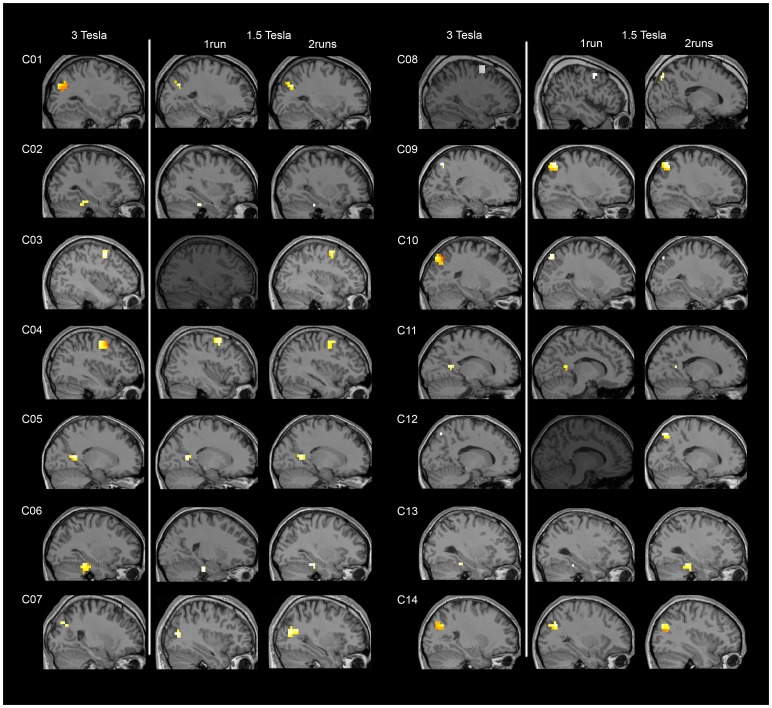
Example of individual results for the motor imagery task versus rest.For each subject, the ROI showing highest consistency across scanning sessions is displayed: occipito-parietal junction (C01, C07 C14), parahippocampal cortex (C02, C06, C13), dorsal premotor cortex (C03, C04, C08 at 3T and 1 run at 1.5T), retrosplenial cortex (C05, C11), and precuneus (C08 at 1.5T, C09, C10, C12). Participants C03 and C12 failed to show significant activation in the scanning session at 1.5T when only 1 run was analyzed but succeeded when both runs were analyzed. Results are thresholded at a FWE-corrected p<0.05.